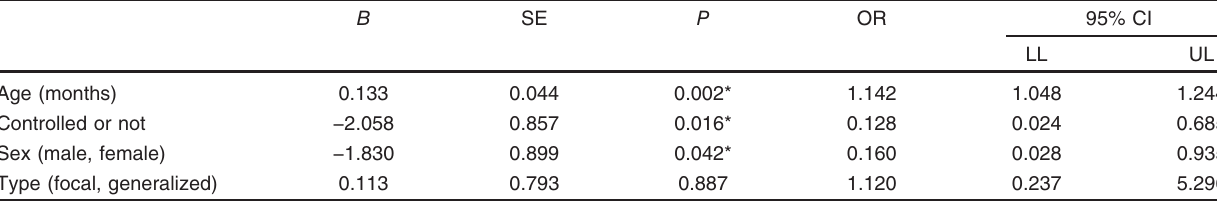
Table 8 Logistic regression for age, treatment control, sex, and type of